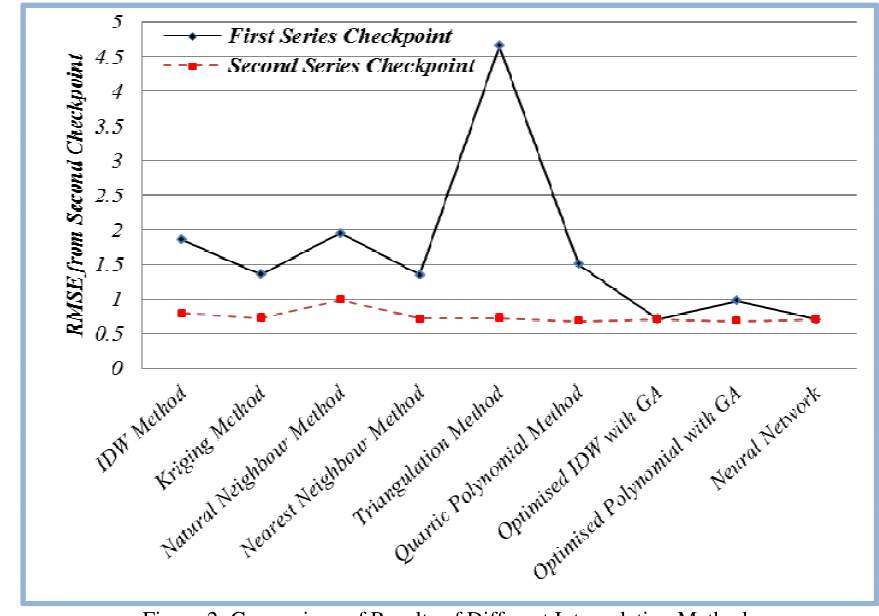
Figure 2: Comparison of Results of Different Interpolation